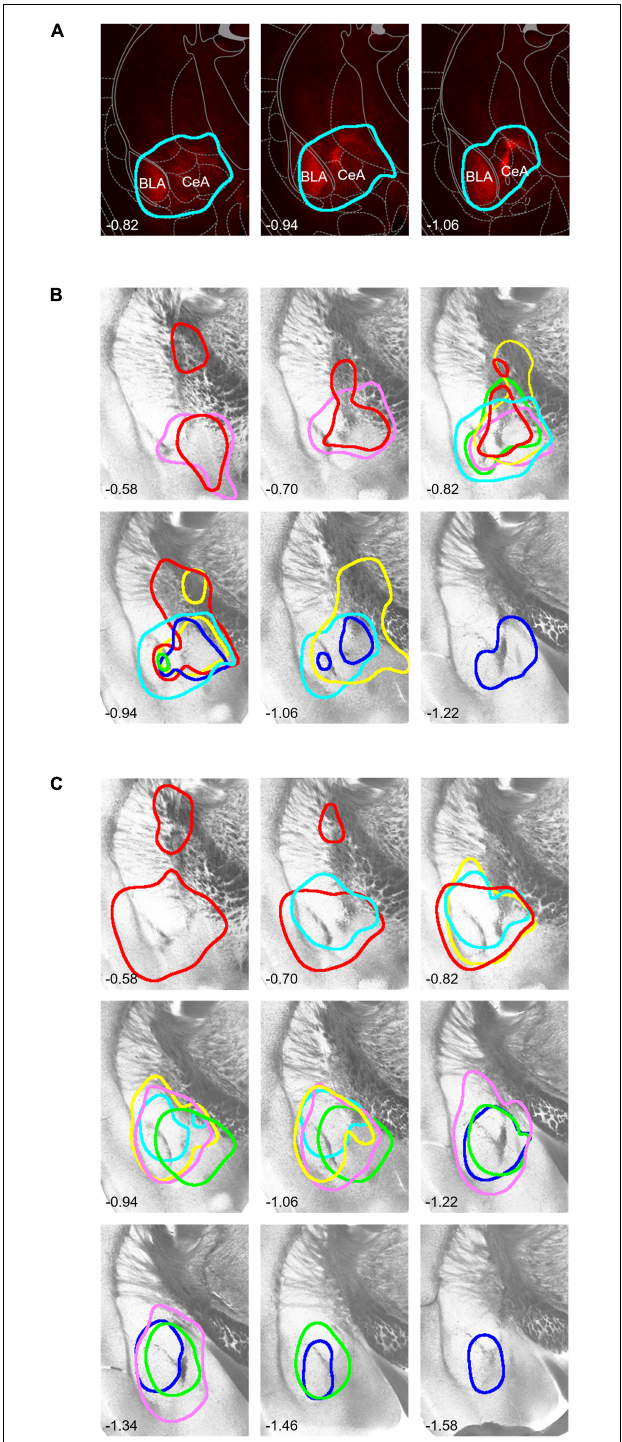
FIGURE 4 | Histological identification of the area with DREADD expression. (A) Representative examples of mCherry fluorescence visualized 5 weeks after local injection of hM4D(G i )-mCherry–expressing viral solution into the right amygdala. The numbers on the bottom-left show the anterior-posterior level from bregma [also for (B,C) ]. The expression area is surrounded by a light